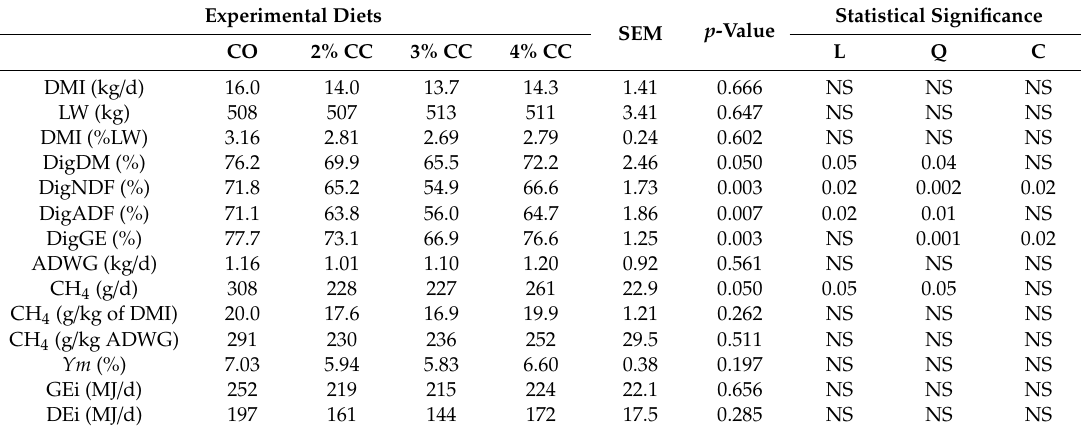
Table 3. E ff ects of increasing levels of Cymbopogon citratus supplementation on dry matter intake, digestibility, live weight gain and methane production in F1 beef steers fed a total mixed ration in Experiment